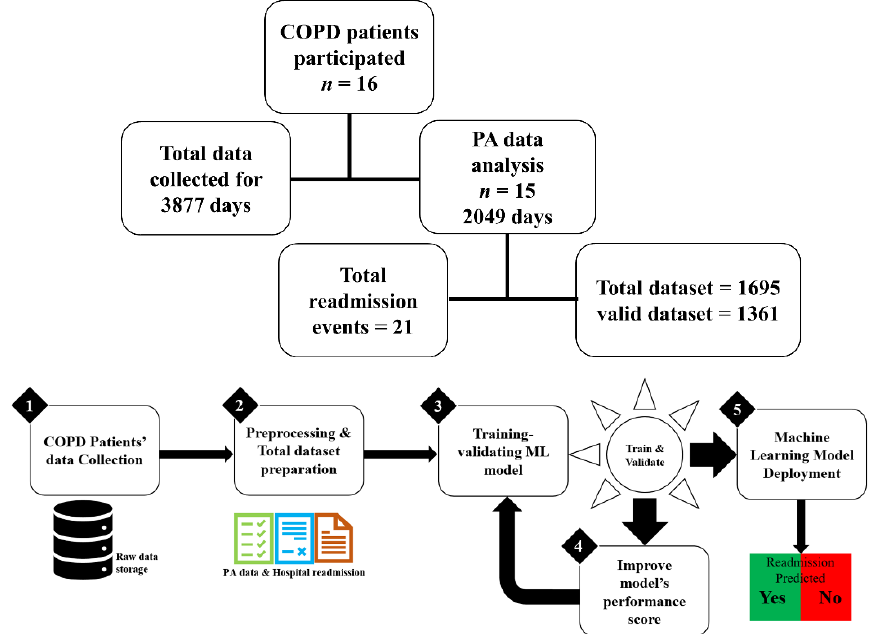
Figure 1. Patient data collection details and an overview of research methodology.